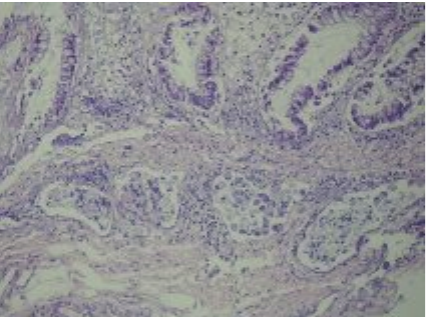
Figure 2: A number of signet cells regarding signet cell carcinoma can be seen in the submucosal layer of vascular structures. (H&E;